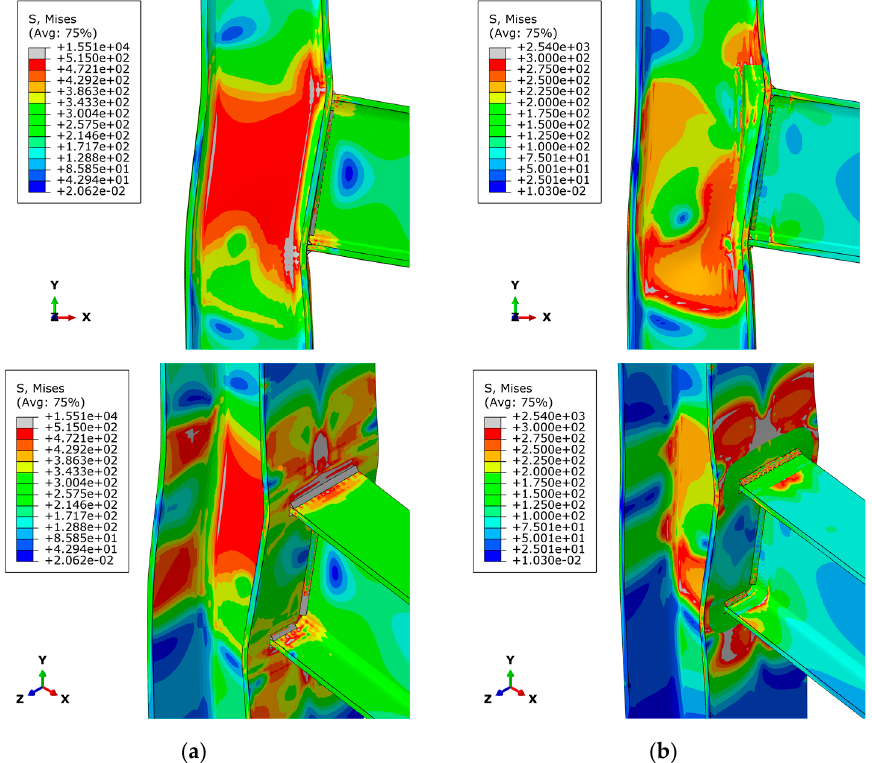
Figure 9. Failure modes of the beam-to-column joint at maximum force: ( a ) steel; ( b ) aluminium